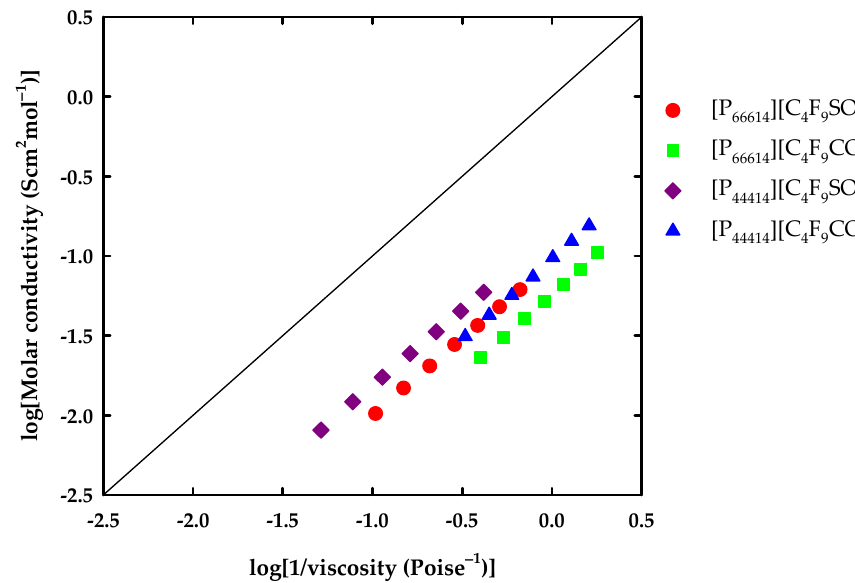
Figure 6. Walden plot for the synthesized fluorinated ionic liquids.